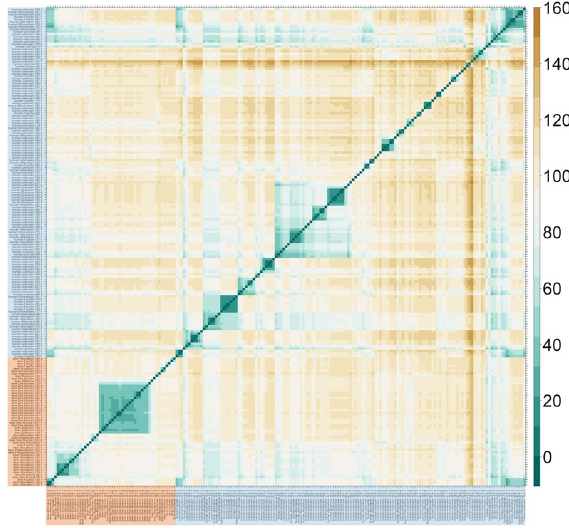
Figure 3. Inferred number of intermediate cases in the transmission chain between each pair of sampled cases. Cases are shown on the left vertical and horizontal axes, where deer cases are highlighted in orange and human cases in blue. The colour scale of the number of intermediate cases is indicated on the right vertical axis.